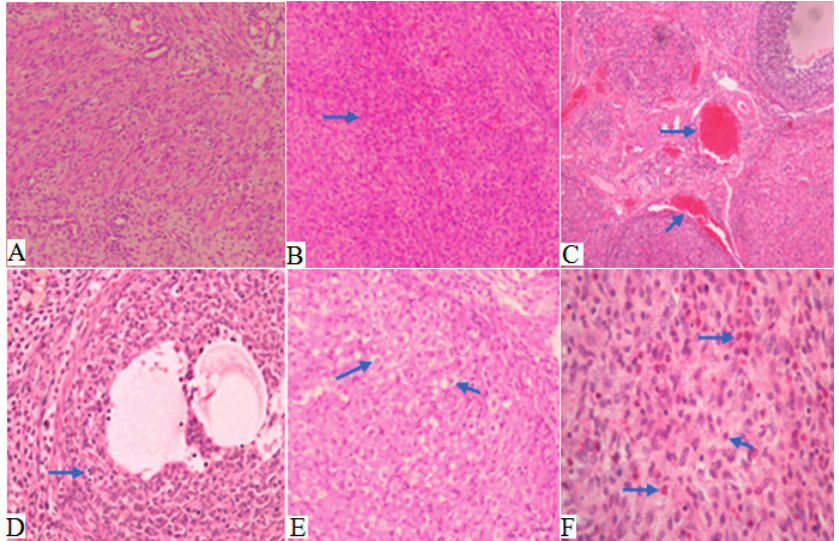
Figure 3. Effects of Ni NPs on histopathology of ovaries in female rats. The control group ( A ); 15 mg/kg BW ( B ); 45 mg/kg ( C – E ); Ni MPs group ( F ). Original magnification was 100×, 200× and 400× (100× refers to picture A , B and C ; 200× refers to picture D and E ; 400× refers to picture F ). The arrow on ( B ) and ( C ) points to vascular dilatation and congestion, on ( D ) it points to Lymphocytes, on ( E ) it points to luteal cells, and on ( F ) it points to eosinophils and inflammatory